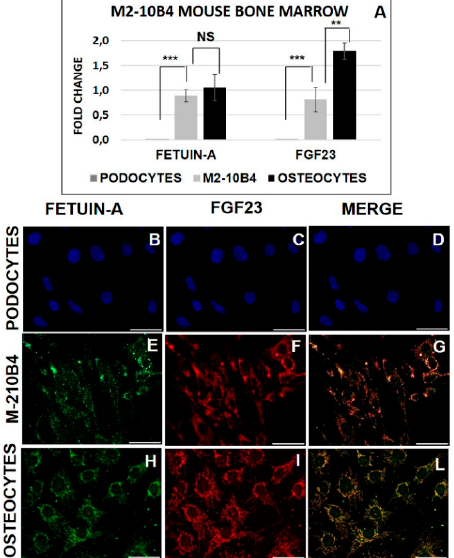
Figure 2. qRT-PCR of Fetuin-A and FGF23 mRNA expression in podocytes (PODO) (control